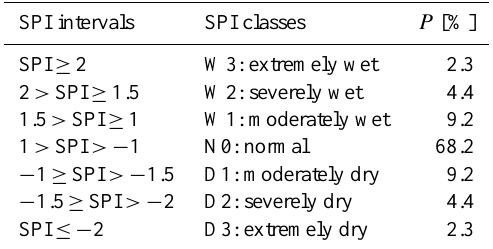
Table 1. Definition of the Standardised Precipitation Index (SPI) classes and corresponding event probabilities ( P